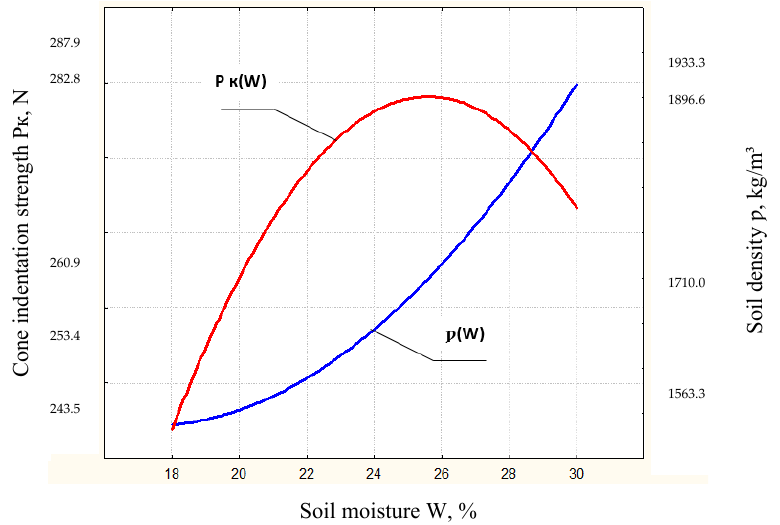
Figure 12. Dependence of the static destruction of soil clods on their density and moisture content.